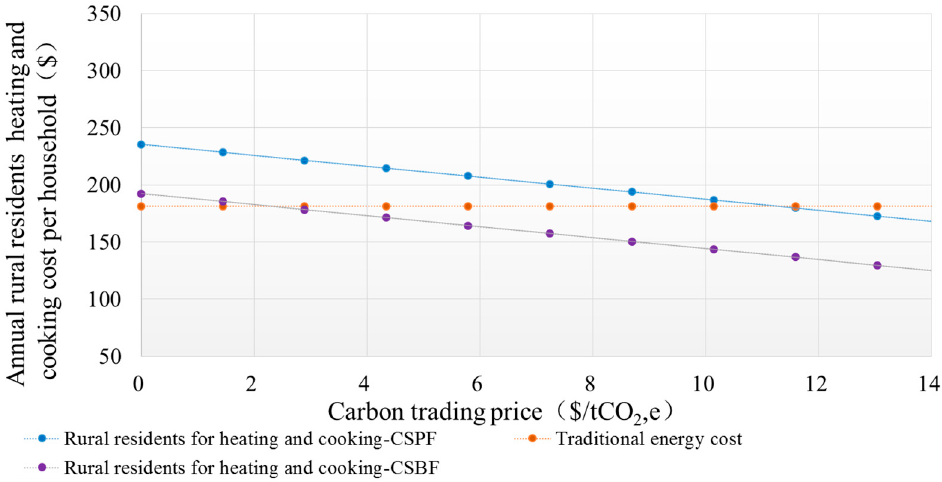
Figure 11. Influence of carbon trading on the economic performance of CSDF for rural residents’ heating and cooking.